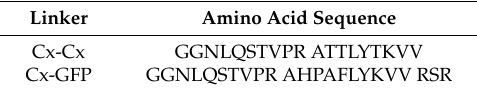
Table 1. The amino acid linkers (one-letter code) between the two concatenated connexins and between the connexin and the GFP tag. The GFP tag was always located at the C-terminus. Linker Amino Acid Sequence Cx-Cx GGNLQSTVPR ATTLYTKVV Cx-GFP GGNLQSTVPR AHPAFLYKVV RSR